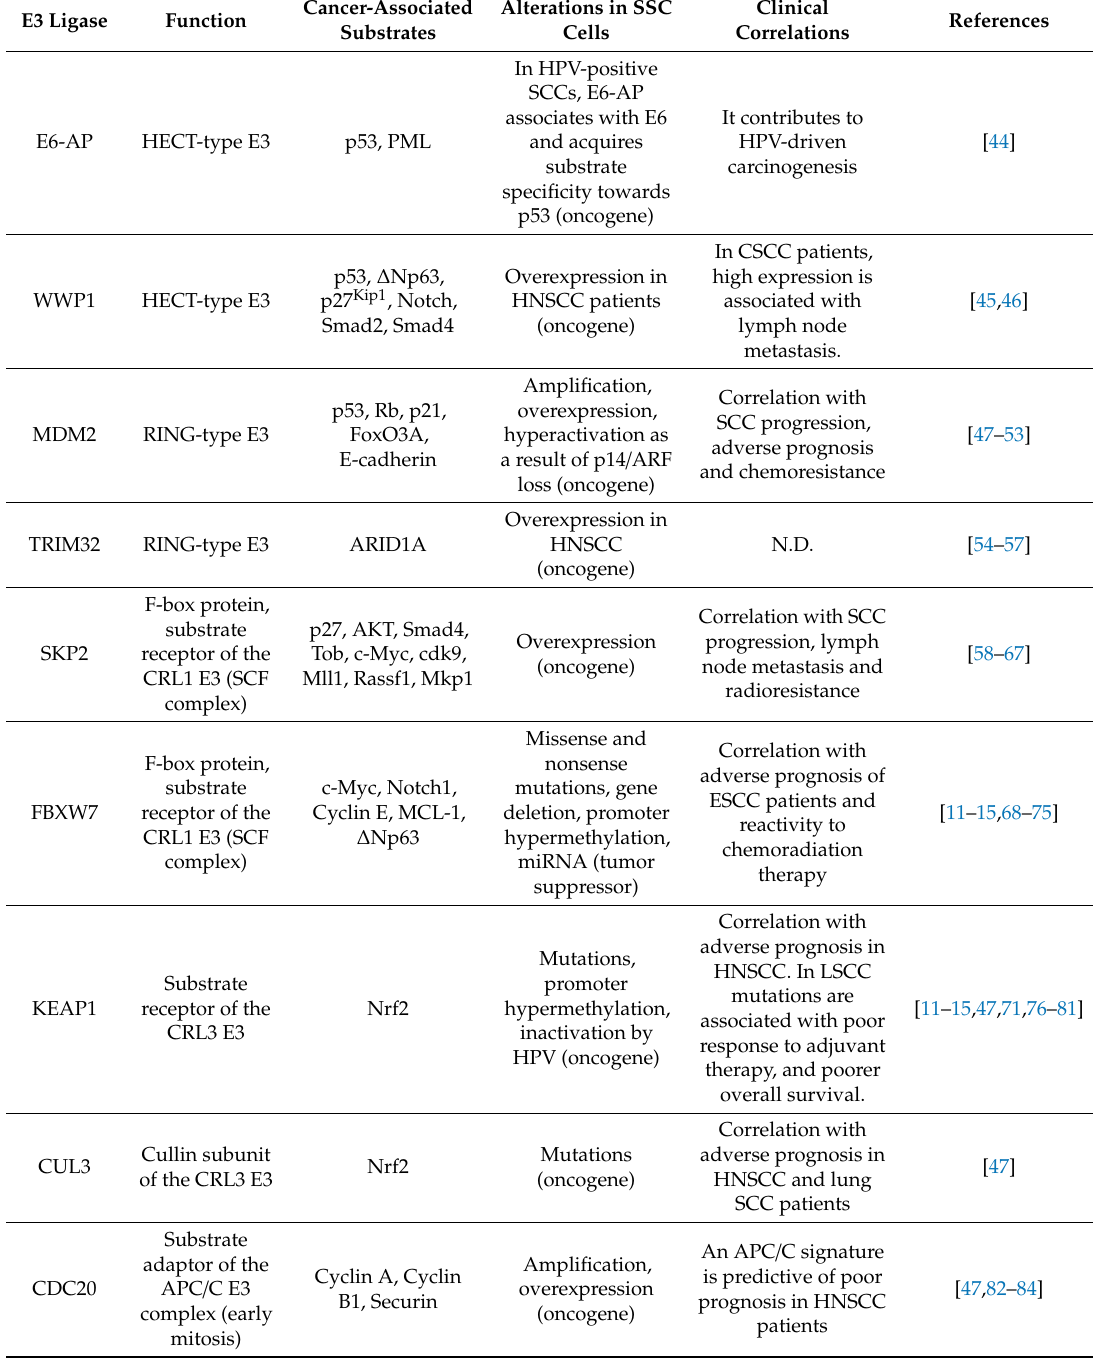
Table 1. Deregulation of the E3s in squamous cell carcinomas